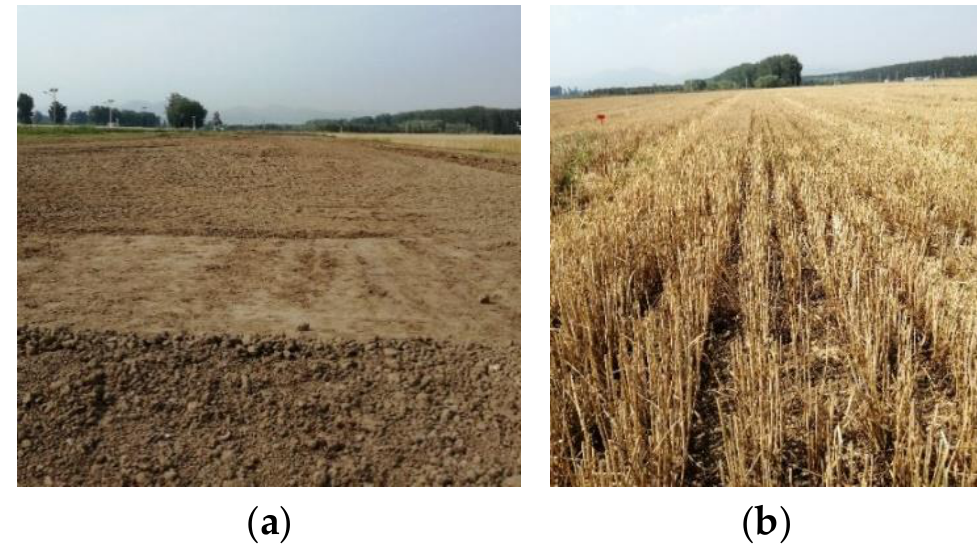
Figure 5. Experimental fields. ( a ) Rotary-tilled field. ( b ) WS field.